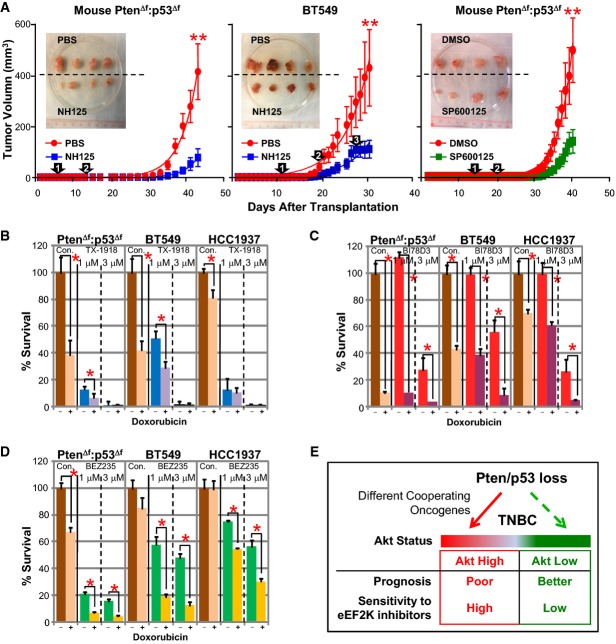
Anti-eEF2K or JNK monotherapy attenuates growth of Pten/p53-deficient TNBC xenograftsDrug–response curves for mouse PtenΔf:p53Δf and human
BT549 tumor xenografts untreated or treated with eEF2K (NH125) or JNK (SP600125) inhibitors. Tumor
cells were injected orthotopically into NOD/SCID mice. Mice
(n = 9 per group) were injected with vehicle or NH125
(1 mg/kg) i.p. daily for 7 days (arrow #1), followed by every second day (arrow #2).
For BT549 cells, mice were switched back to daily treatment for the final 4 days (arrow #3).
SP600125 was administered at 60 mg/kg daily for 5 days (arrow #1) followed by
30 mg/kg daily (arrow #2). Inlets show 4 representative tumors of each group. Significant
differences comparing control with treatment groups were determined by Graphpad Prism 5.0 with
non-linear regression. **P < 0.0001.Response of PtenΔf:p53Δf mouse and human tumor cells to
TX-1918 +/− doxorubicin. Indicated cells were treated with low-dose doxorubicin
(0.1 mg/ml, 170 nM) or 0 (Con), plus 1 or 3 μM TX-1918 for 3 days
and analyzed by MTT assay. Additive effect of TX-1918 plus doxorubicin was observed
(*P < 0.05, t-test).Response of PtenΔf:p53Δf mouse and human cells to BI78D3
(JNK) +/− doxorubicin. Additive effect of BI78D3 plus doxorubicin was observed
(*P < 0.05, t-test).Response of PtenΔf:p53Δf mouse and human cells to NVP-BEZ235
(PI3K/mTOR) +/− doxorubicin. Synergistic effect of NVP-BEZ235 plus doxorubicin was
observed (*P < 0.05, t-test).Our results suggest that combined Pten/p53 loss in human TNBCs induces a range of AKT pathway
activation, depending on different cooperating oncogenic events, which affects prognosis and tumor
response to anti-eEF2K therapy.